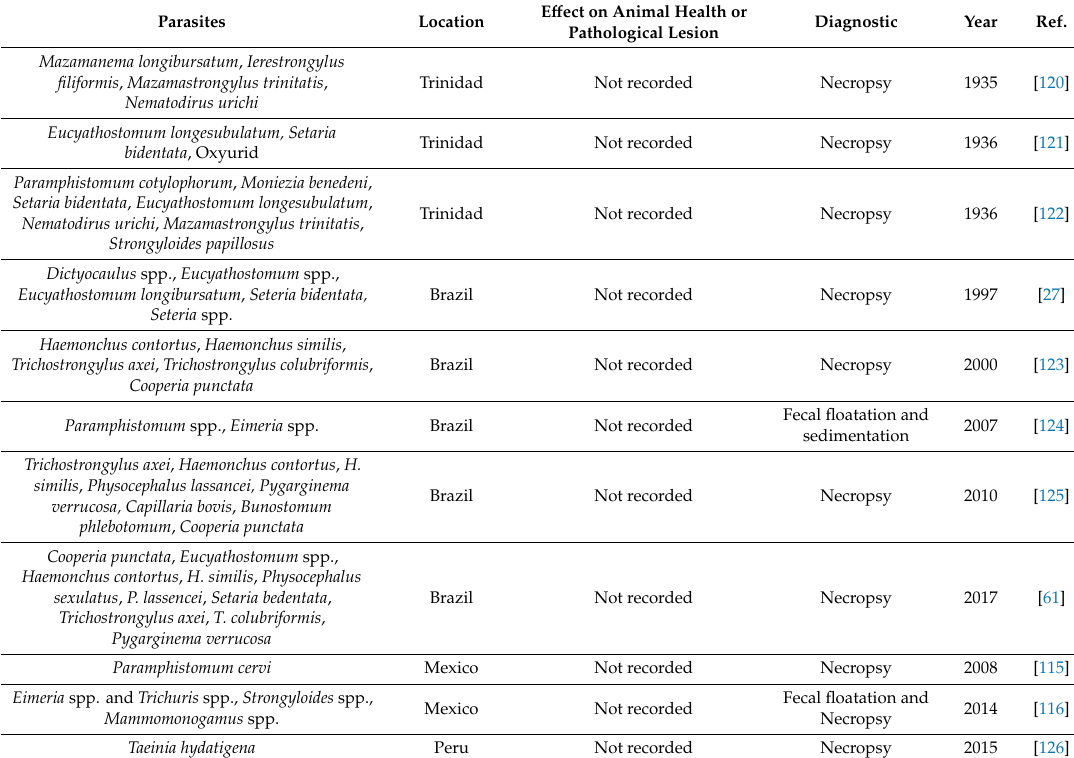
Table 6. Endoparasites found in the Red Brocket deer ( Mazama americana ) at di ff erent